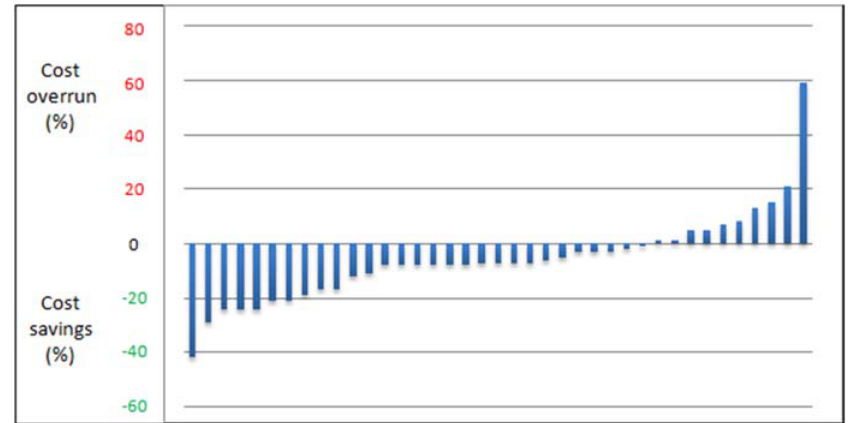
Figure 8. The same large Norwegian projects as shown in Figure 7 illustrate here the actual final total project cost compared with the approved official budget. It is seen that 80% of these projects kept to the budget. This is well in agreement with the ambition for these Norwegian projects, but it is very different to international experiences, where cost overruns are commonplace. The figures are from [19].